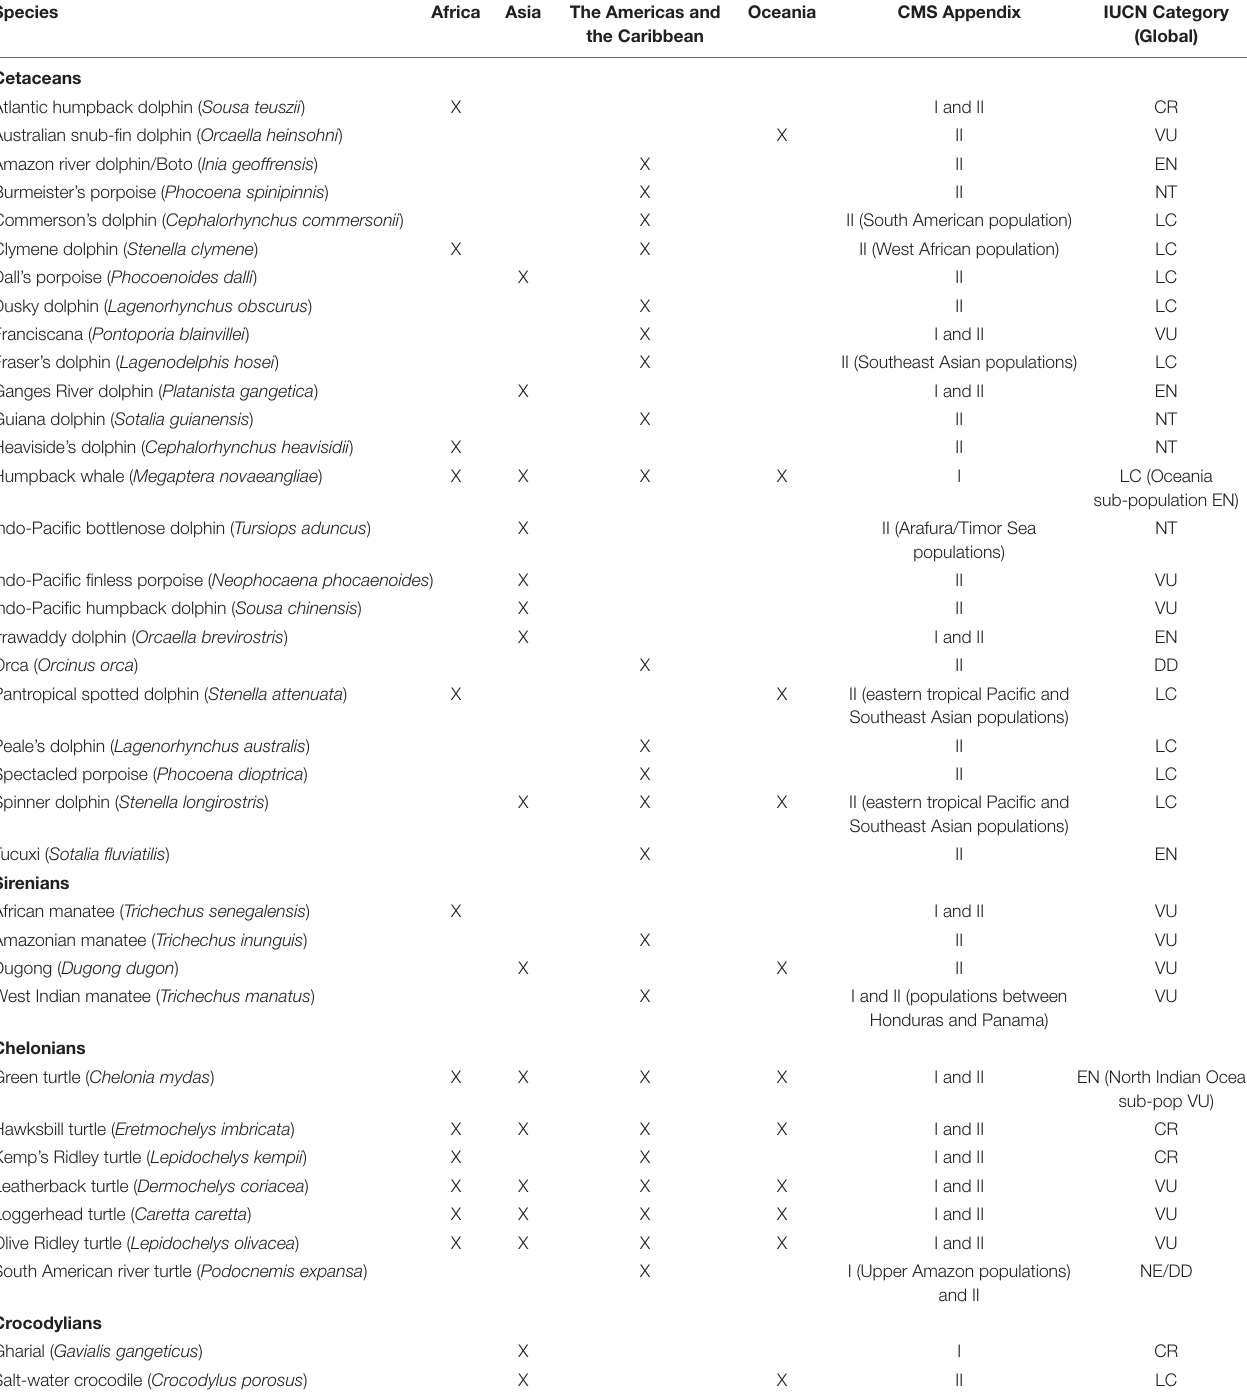
TABLE 1 | CMS Species of Concern by CMS Appendices and Region. Species Africa Asia The Americas and